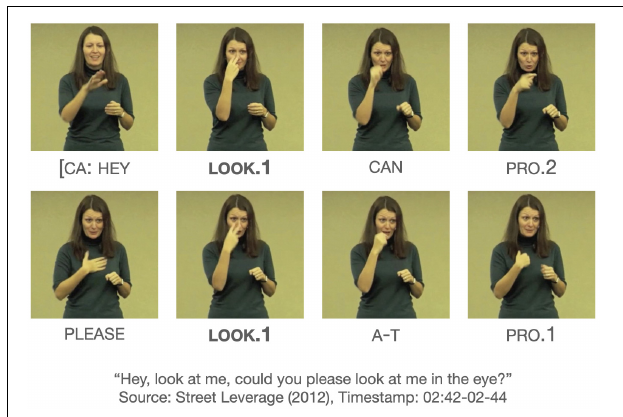
FIGURE 7 | An instance of LOOK /“vision.” Images produced with permission, source information available in the Supplementary Material .